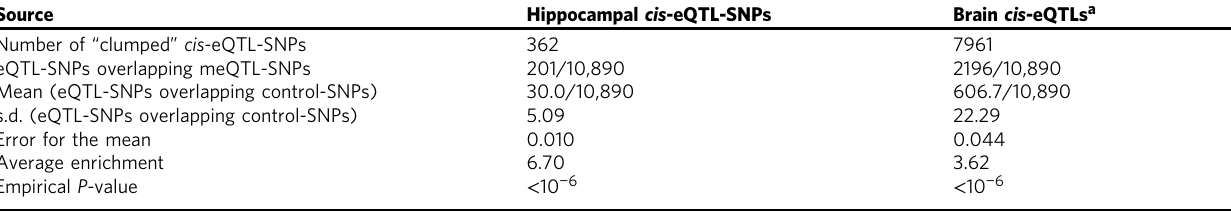
Table 2 Linkage disequilibrium overlap of cis -eQTL-SNPs with cis -meQTL-SNPs